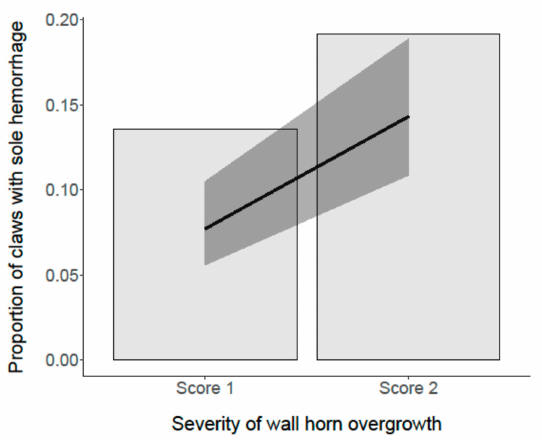
Figure 5. Association between the “severity score of wall horn overgrowth” and the proportion of claws with sole hemorrhage. The black line represents the model estimate, the gray colored area the 95% confidence interval.